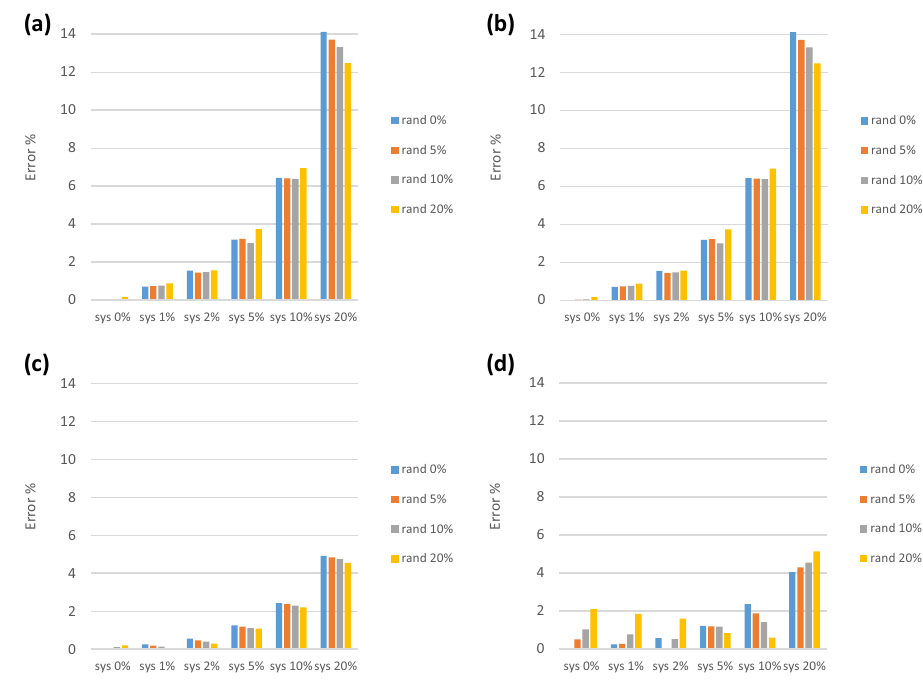
Fig. 6 Final errors of the his- tory matching in estimating: a hydrocarbon liquid production; b gas production; c porosity; and d permeability for all the employed data sets for the wet gas reservoir (“sys” and “rand” refer to systematic and random errors, respectively).